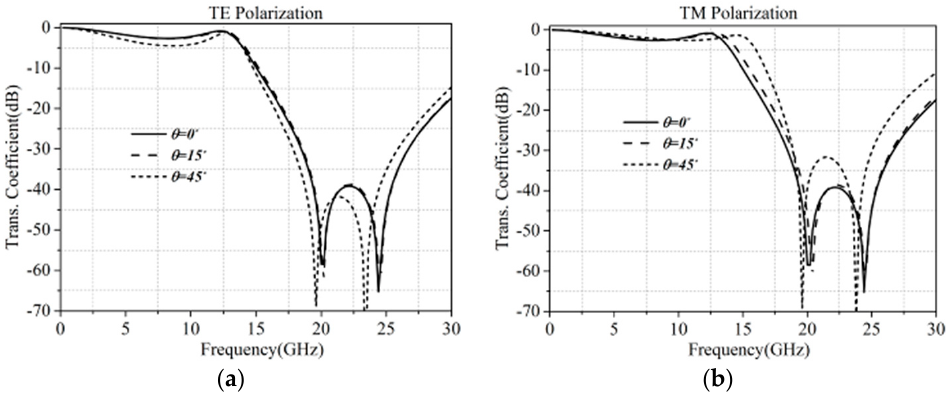
Figure 7. Transmission coefficients for oblique incidences with different angles on the harmonic suppression (HS) FSMSE, ( a ) TE polarization and ( b ) TM polarization.